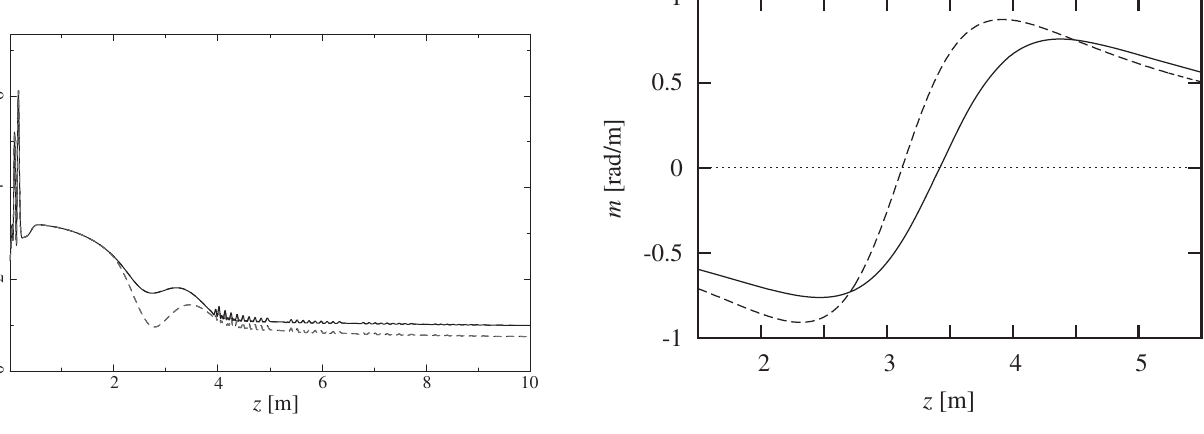
FIG. 15. Development of the slopes of two slices in the drift behind the solenoid. One slice is in the center (solid line), and the other in the head of the bunch (broken line). No acceleration is applied in this